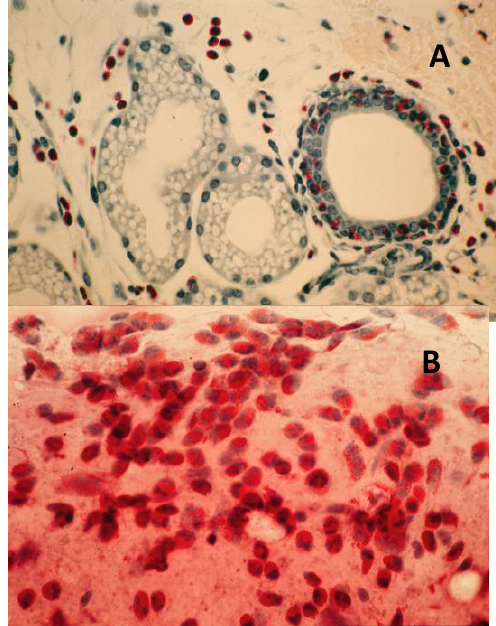
Figure 5. Induction of down regulation in CALTs and eosinophil infiltration. Panel A; heavy eosinophils infiltration into GCs. Panel B; heavy eosinophils infiltration in conjunctival secretions from animals that were repeatedly challenged with topical application of FLOA and systemically immunized with A. Suum. Reproduced from Khatami et al .